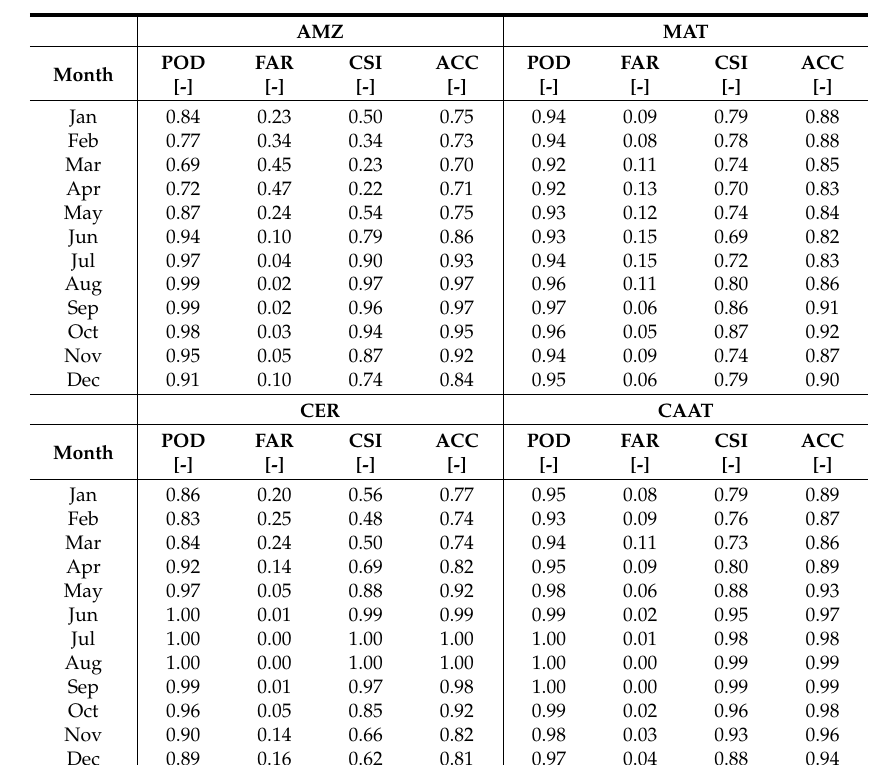
Figure 12. As per Figure 8, but for the MSWEP rainfall product. Table 9. As per Table 7, but for the MSWEP rainfall product.